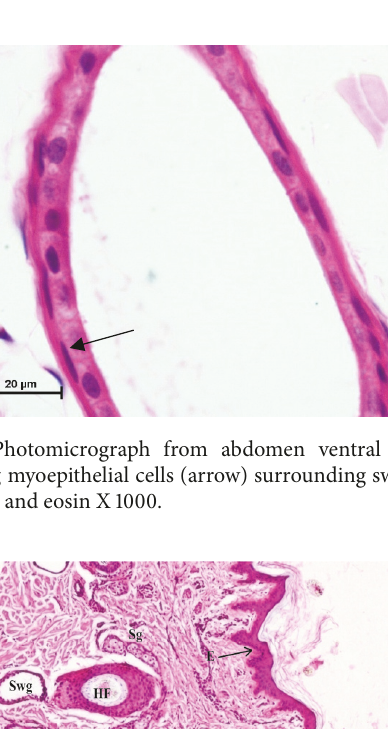
maximum sweat gland diameter was observed in abdomen region followed by thorax, head, neck, and tail but difference was significantly higher (p < 0.05) than in neck and tail regions only as reported by Patil et al . [30] in cattle and Das et al. [29] in cattle and